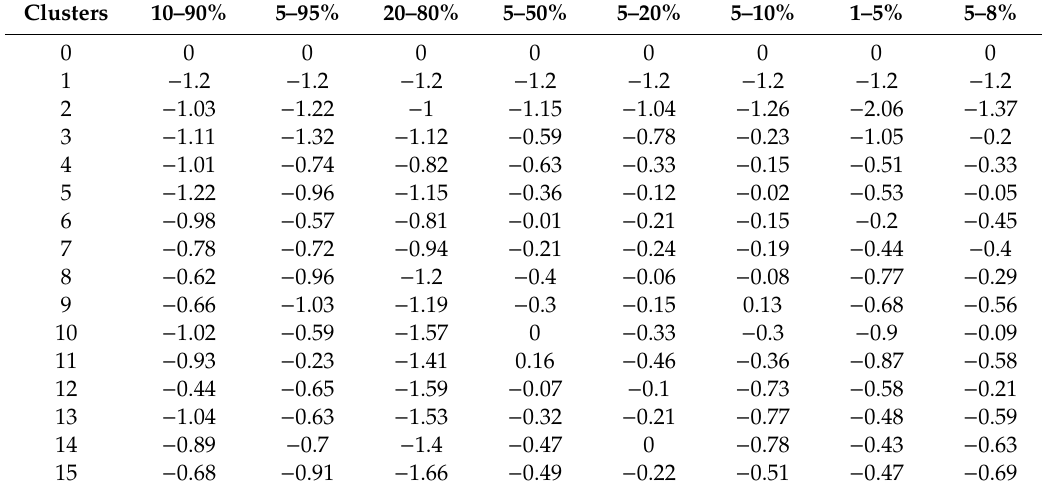
Table 3. Evolution of the QSS0. 1%,5%, depending on the number of clusters and couples of quantiles